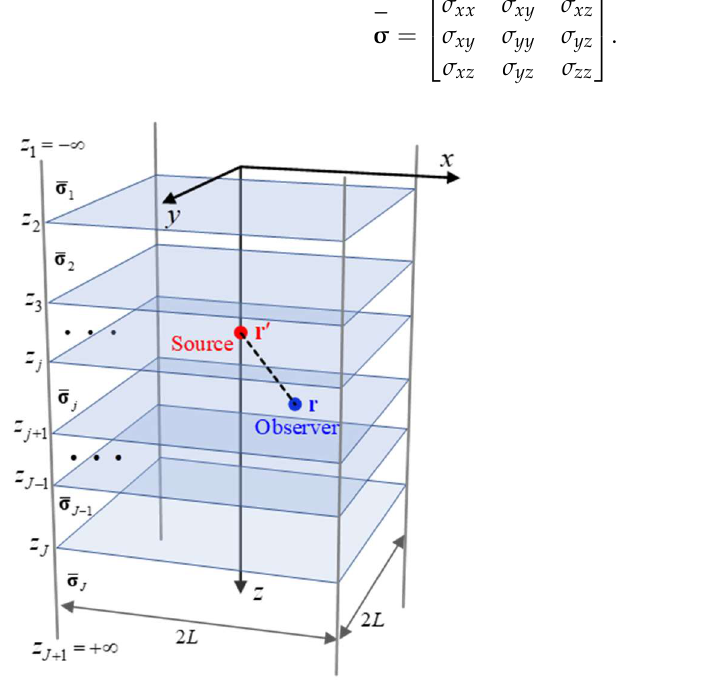
Figure 1. The infinitely long rectangular region with a square cross-section and a layered anisotropic medium.